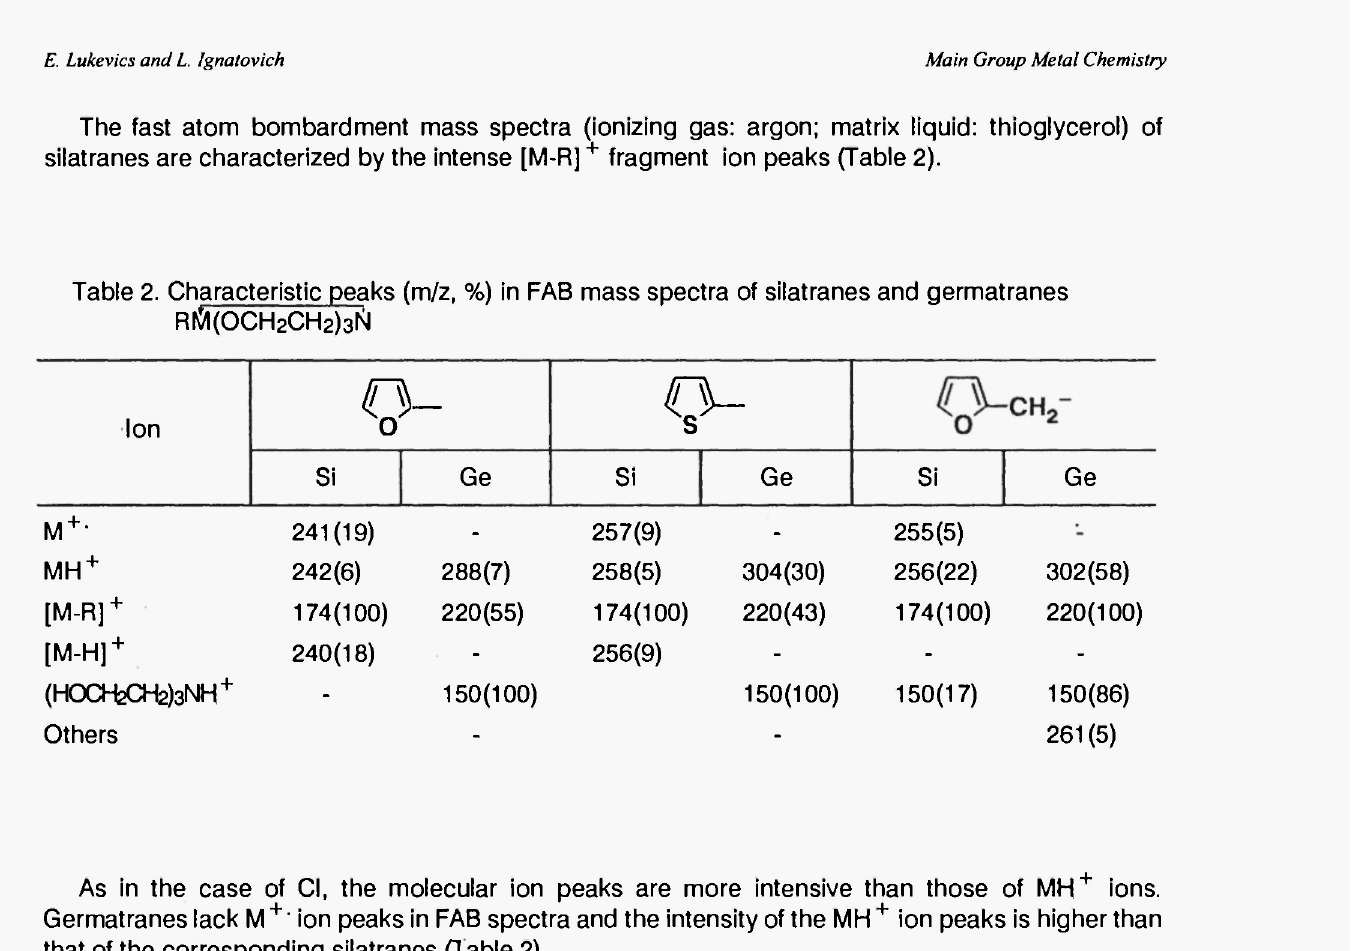
Table 2. Characteristic peaks (m/z, %) in FAB mass spectra of silatranes and